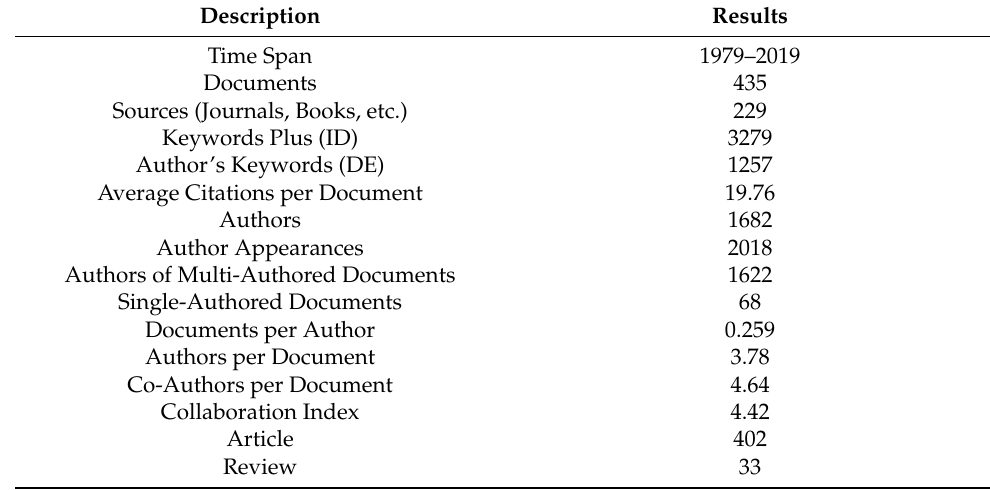
Table 1. Main summary information retrieved on EOS and PM studies